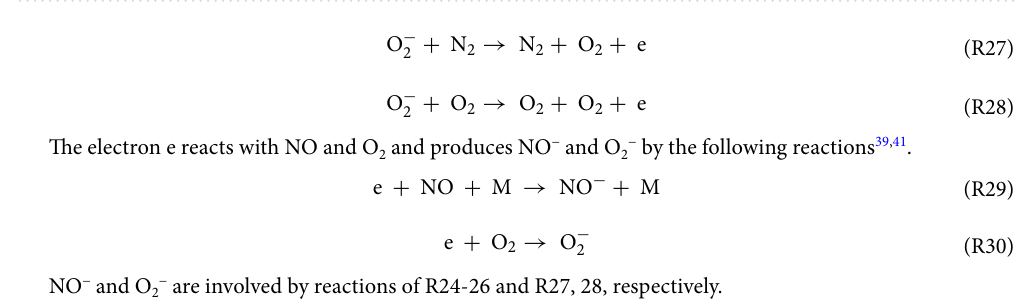
Figure 6. SEM image of the same seed ( a ) before plasma irradiation and ( b ) after plasma irradiation for 10